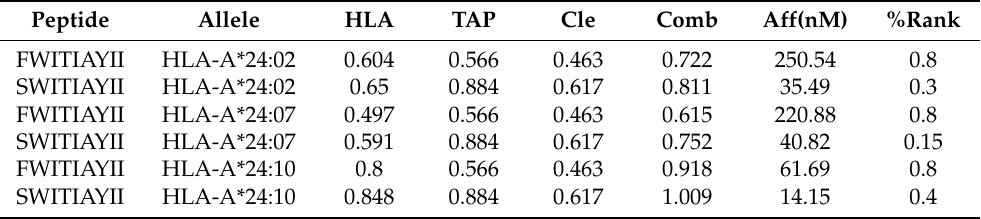
Table 6. Comparison of binding affinity between the ancestral (FWITIAYII) and mutant (SWITI- AYII) peptide. The calculation was made using NetCTLpan 1.1., which also predicted the peptide processing (proteasomal cleavage and TAP transport efficiency) inside the